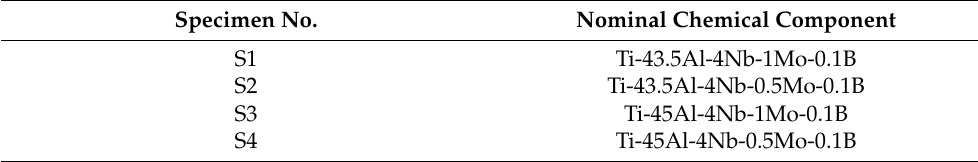
Table 1. Nominal compositions of the present TiAl alloys (at.%). Specimen